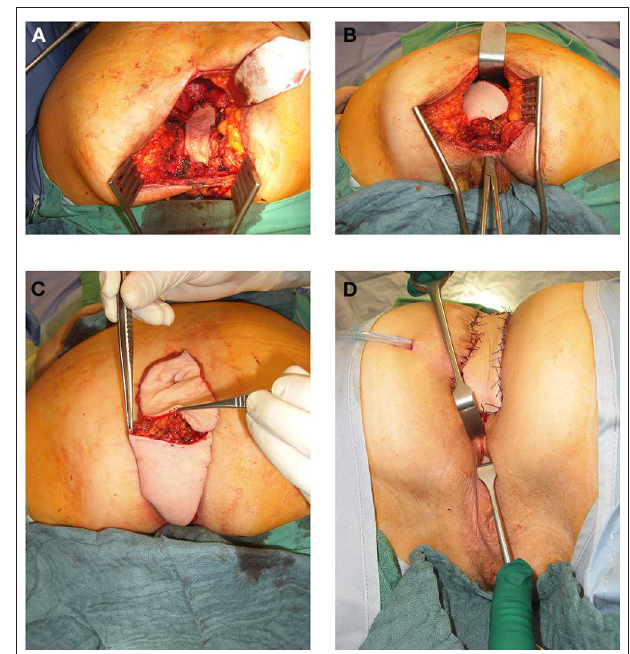
FIGURE 4 | (A) 64 year old female patient with resectional defect after exenteration with removal of posterior vaginal wall und parts of the lateral aspects. (B) Transpevlic pull through of the VRAM flap into defect with patient in prone position after cylindrical excision. (C) VRAM flap skin island split into two parts to reconstruct the vaginal wall and covert he sacral perineal defect when vulvar entrance can be preserved. (D) External coverage of sacral / perineal defect with partially divided VRAM flap skin island, while second half of skin paddle was used to reconstruct the vaginal